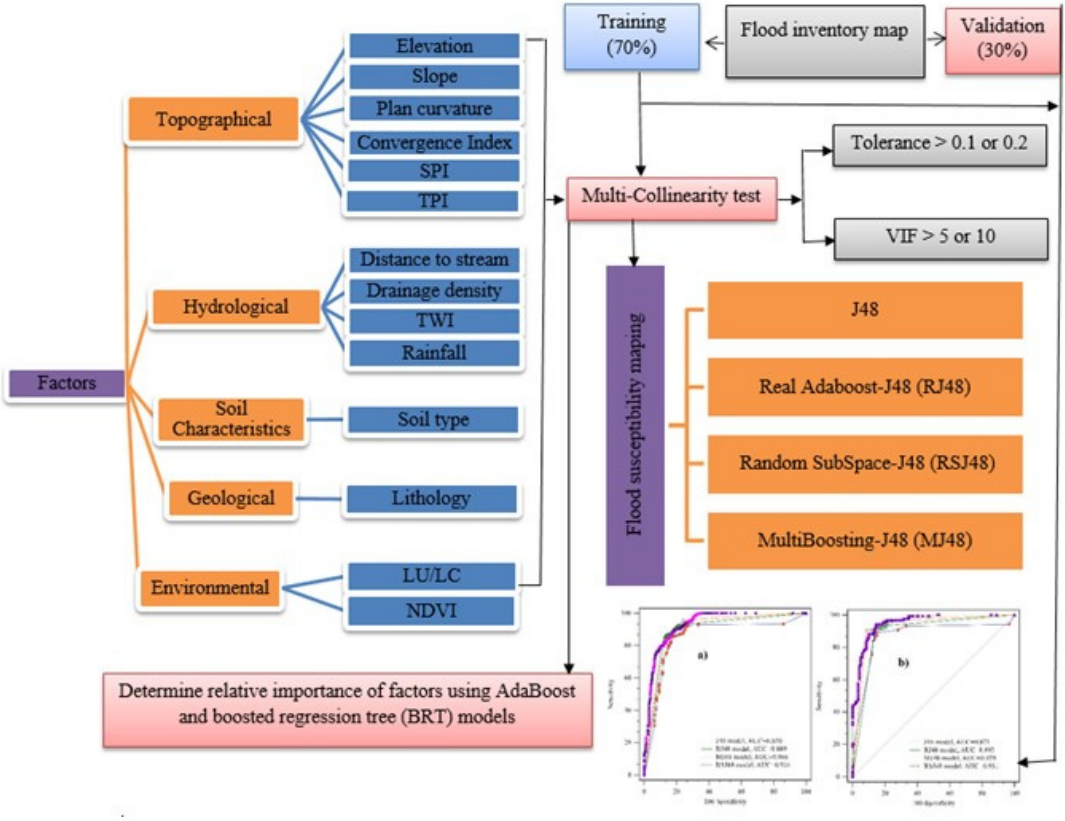
Figure 2. Flowchart showing the methodology of the present work.